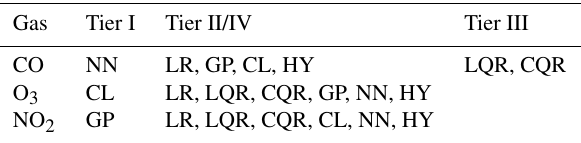
Table 3. Performance of iRAMP calibration models with respect to EPA air quality sensor performance guidelines as assessed at the CMU site. Entries in the table denote which models meet the corre- sponding guidelines for each gas (LR: linear regression; LQR: lim- ited quadratic regression; CQR: complete quadratic regression; GP: Gaussian process; CL: clustering; NN: neural network; HY: hybrid random forest–linear